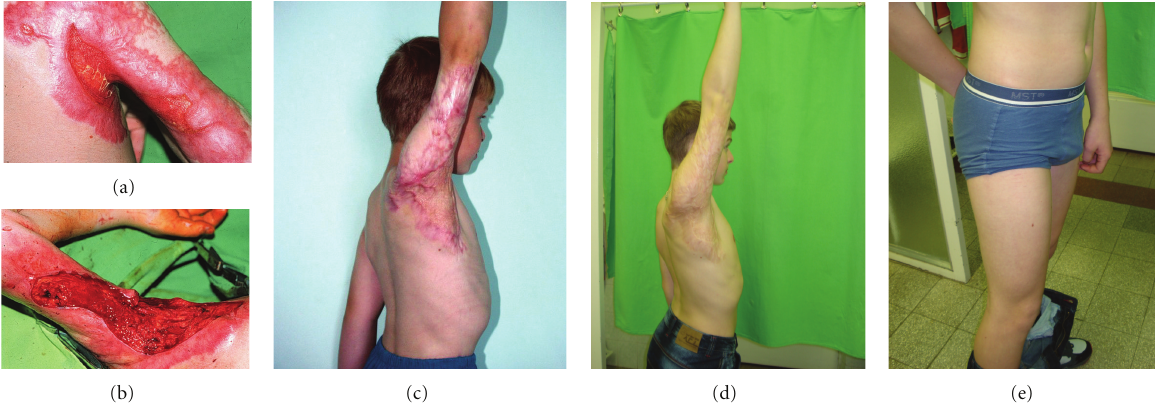
Figure 2: Patient no. 3, 8-years-old male su ff ered 4 months earlier from full-thickness burn on 20% body surface area and had conservative treatment (at another institution). (a) Upon admission: spontaneous rupture of scar that was causing severe axillary contracture. (b) Intraoperative photograph after removal of scar tissue. Full axillary function following sandwich grafting with Alloderm and thin autologous skin at (c) 3 months and (d) 7 years postoperatively. (e) No visible trace of previous harvesting of autograft skin can be seen at the donor site on right thigh (picture taken at 7 years